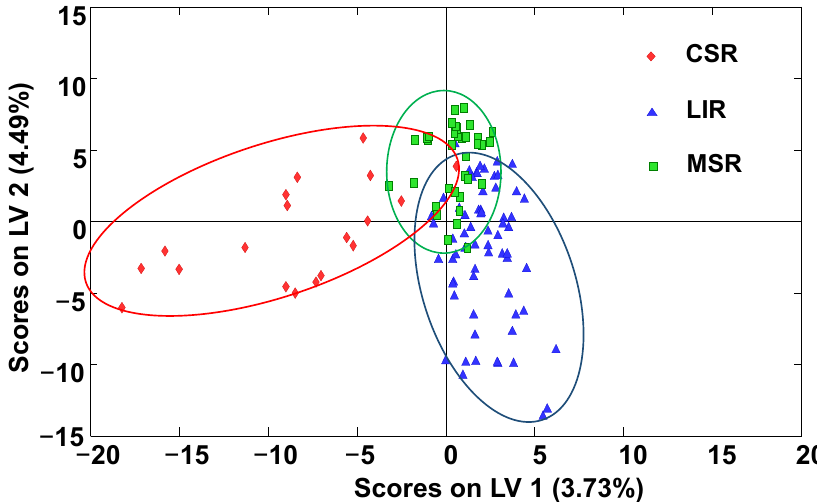
Figure 5. PLS–DA score plots of LV1 vs. LV2 when using non-targeted LC–HRMS fingerprints as chemical descriptors for climatic geographical production region (two LVs were used to build the model). CSR: Cantabrian Sea region; LIR: landlocked inland region; MSR: Mediterranean Sea region.